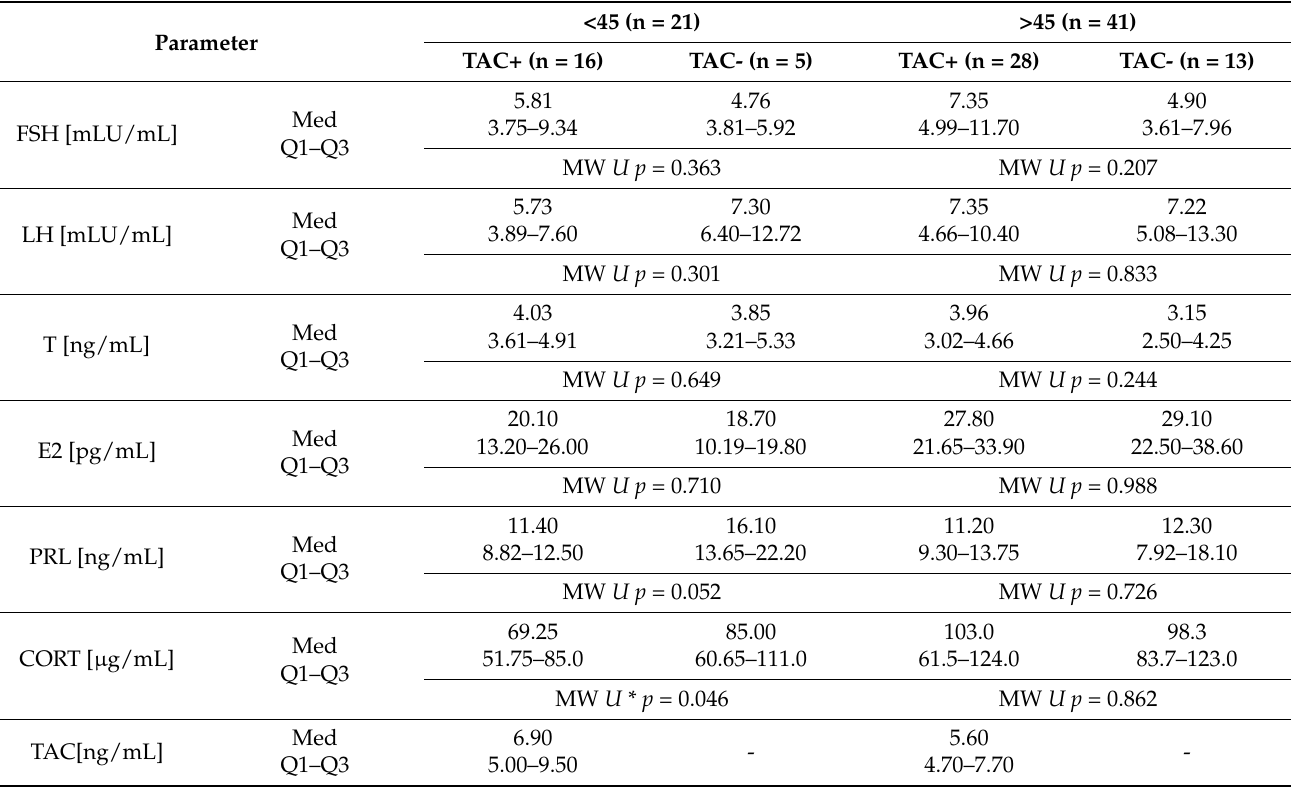
Table 5. Hormone and TAC concentrations in blood of male renal transplant recipients under and over 45 years